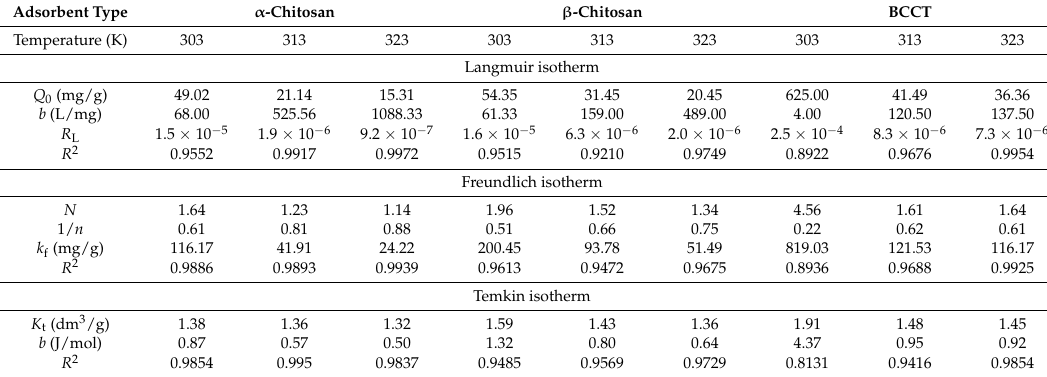
Table 1. The isotherms and parameters for Reactive Blue 221 dye adsorption at different temperatures and by different adsorbents (tested at pH = 5 and t = 24